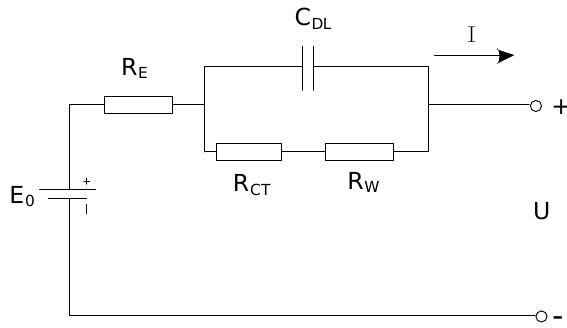
Figure 8. Second-order Randles equivalent circuit model.